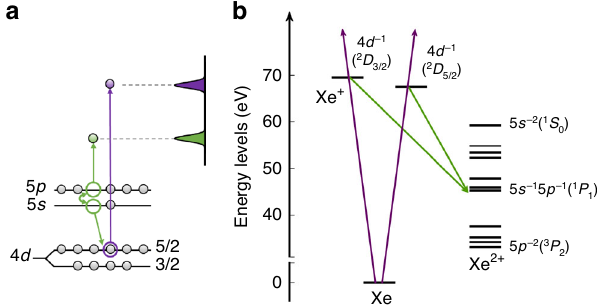
Fig. 1 Excitation scheme. a Schematic illustration of Xe 4 d photoionization (violet) and Auger decay processes (green) after absorption of XUV radiation. b Xe energy diagram showing the Xe + intermediate and Xe 2 + fi nal states